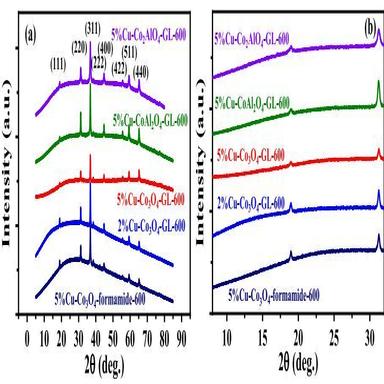
XRD profiles of Cu2+-Co3O4/NC, 5%Cu2+-Co2AlO4/NC-glycerol-600 and 5%Cu2+-CoAl2O4/NC-glycerol-600 materials.